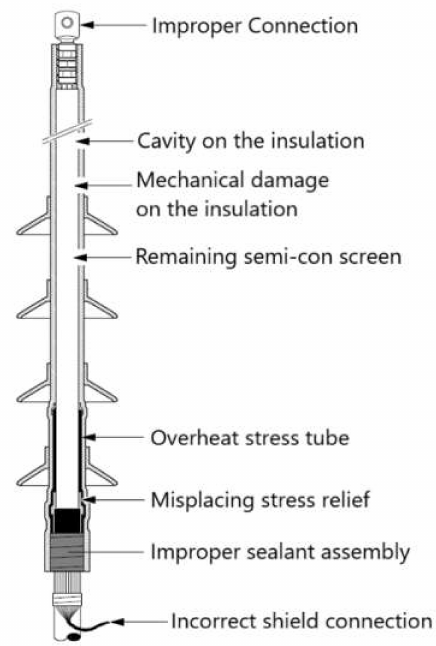
Figure 2. Defects of cable termination